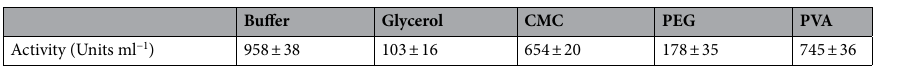
Table 3. Activity of tyrosinase (1 mg ml −1 ) in buffer and ink solutions with various viscosity